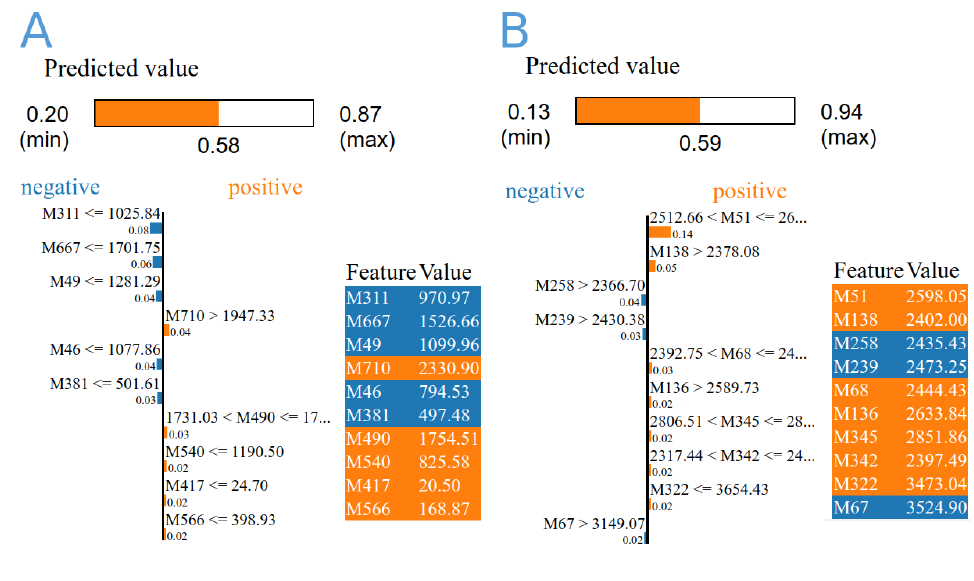
Figure 10. The importance score of the top 10 diabetes-related biomarkers derived from gene expression data from GSE15932, GSE55098 ( A ), and GSE30208 by using extra-tree regressor and local interpretable model-agnostic explanation algorithms ( B ). The colours represent the feature values from low to high (from blue to